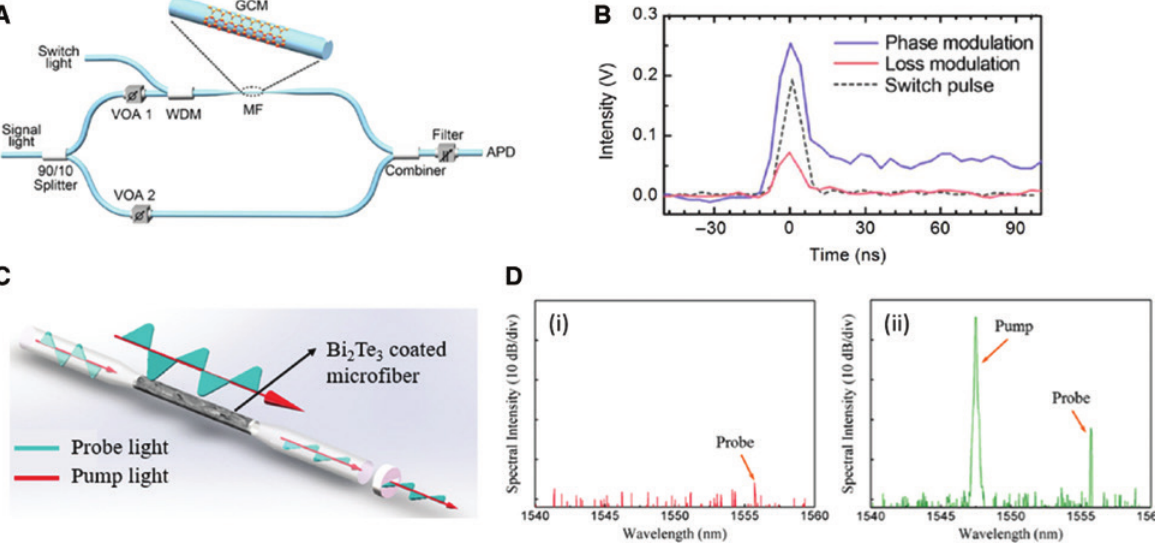
Figure 6: 2D materials-based Kerr modulation with fiber. (A) Schematic experimental setup of an all-optical Kerr modulator by graphene-clad microfiber with a diameter of 1.1 μ m. (B) Temporal profiles of pulse-modulated signals from the modulator (blue line) compared with the loss-based modulation (red line) and the switching pulse (black dashed line) in nanosecond time scale [142]. (C) Schematic model of topological insulators Bi (D) Output spectra of the modulator shown in part (c) without (i) and with (ii) the pump [143]. (A and B) Reproduced with permission